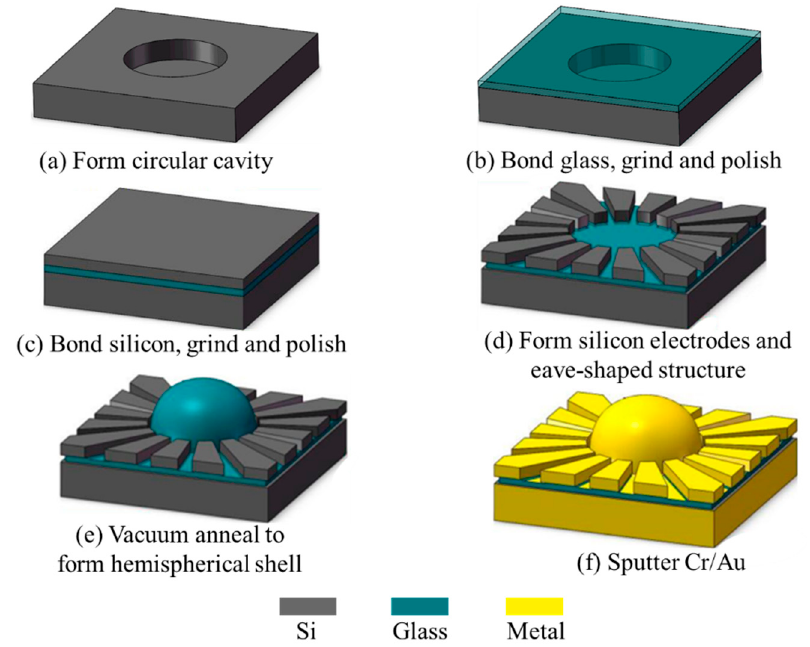
Figure 6. Fabrication process sketch.